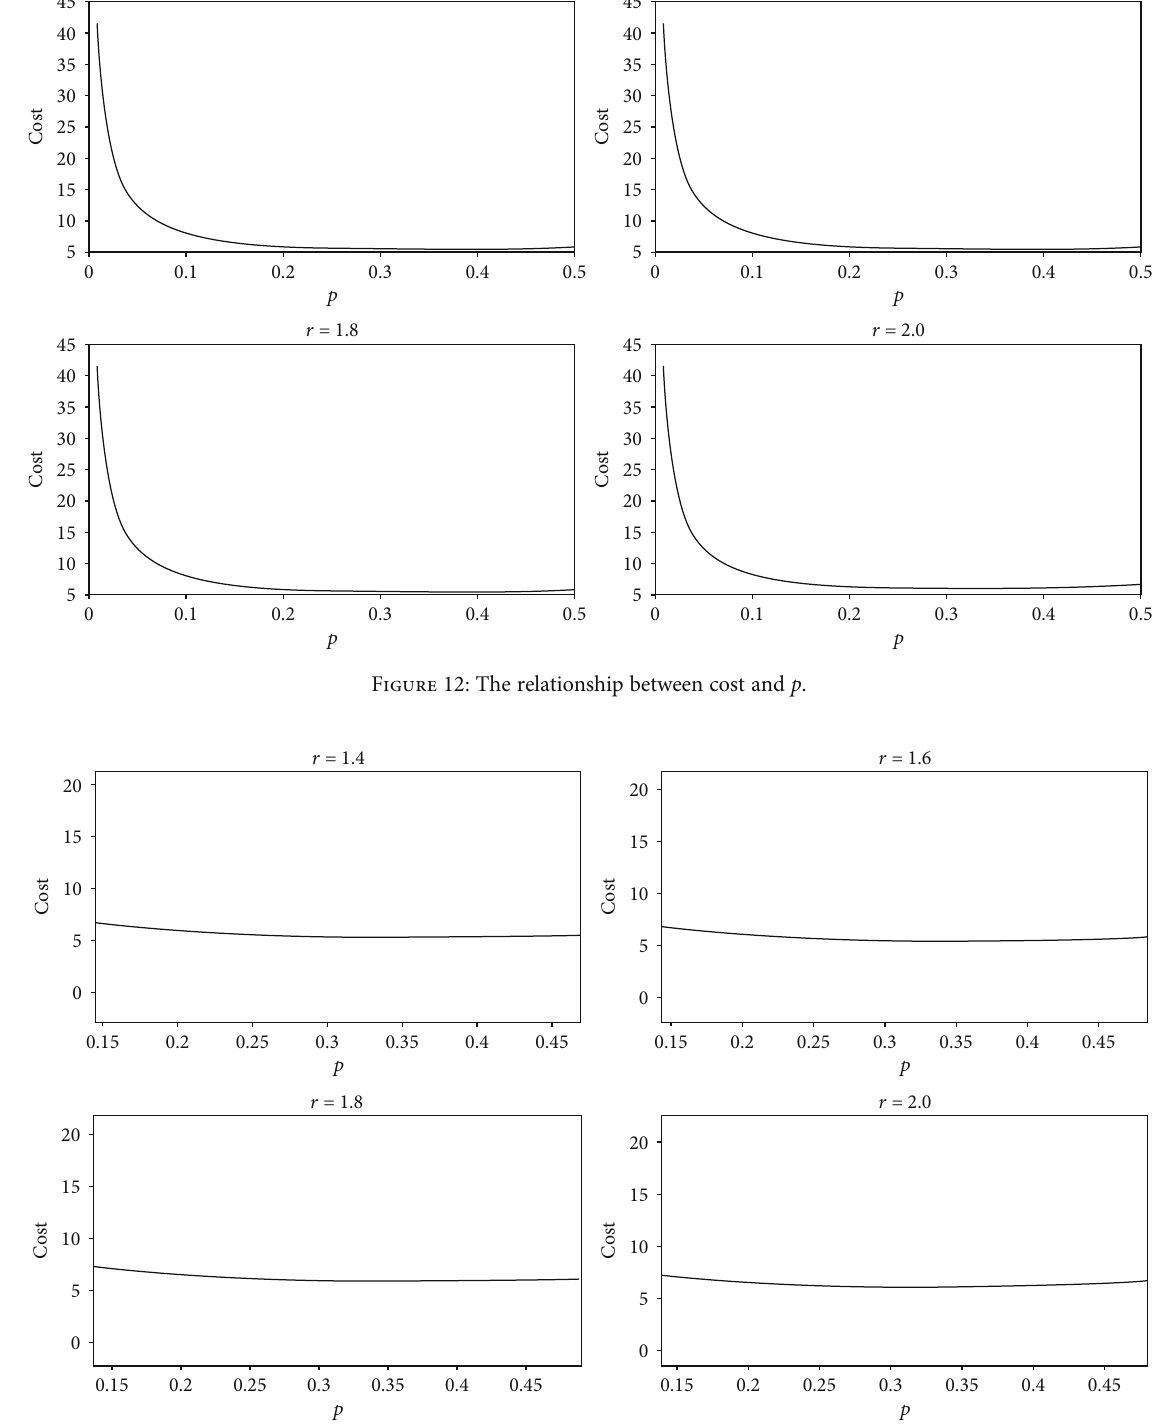
Figure 13: The relationship between cost and p